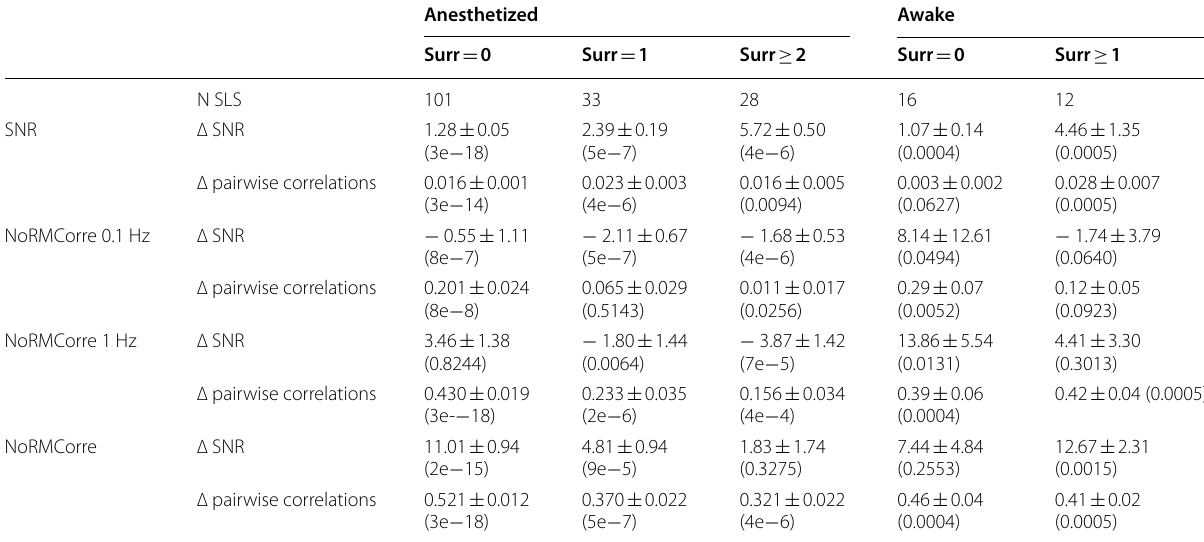
Table 4 Small artefacts motion correction